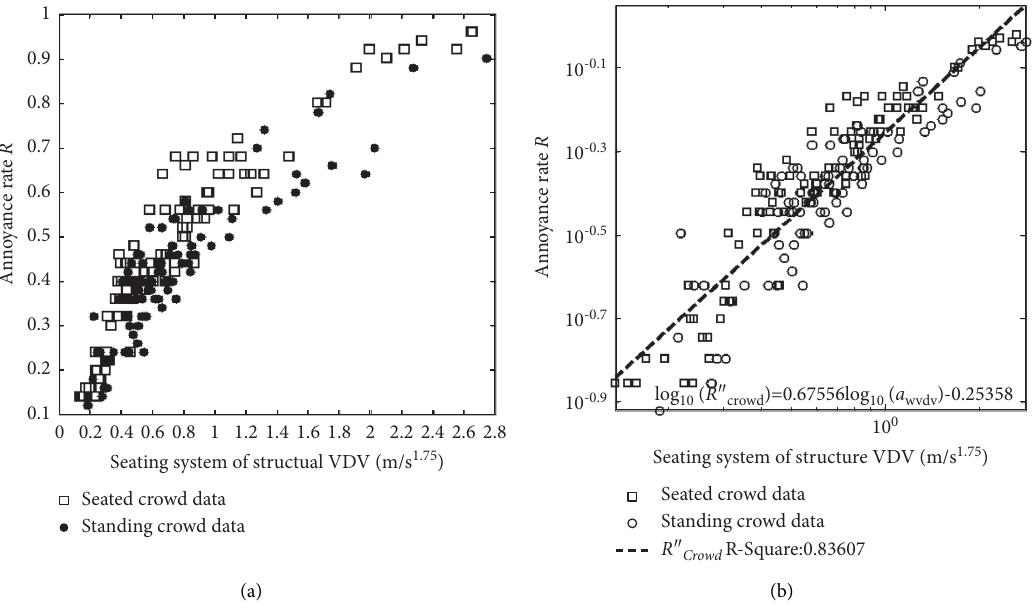
Figure 10: The distribution of crowds annoyance rate in human-induced structural vibration. (a) Cartesian coordinate system; (b) logarithmic coordinate